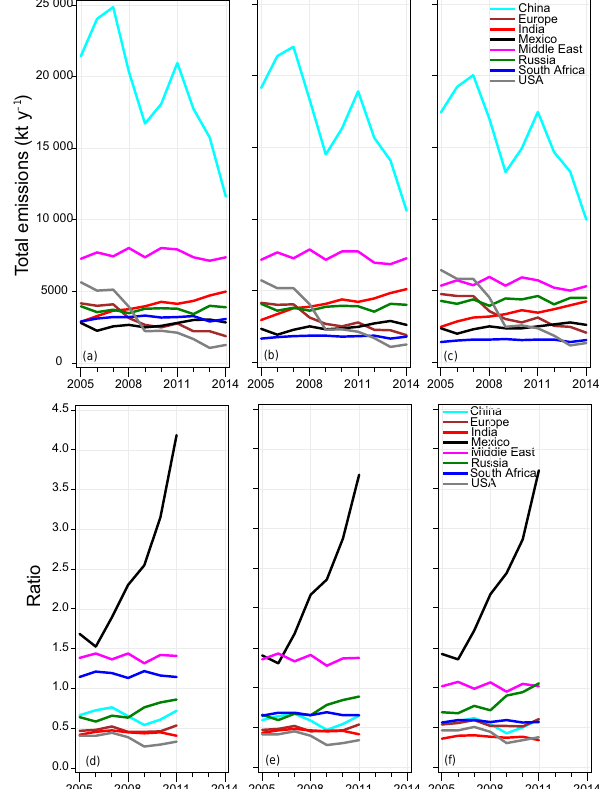
Figure 13. (a – c) Time series of total annual SO 2 emissions by country/region calculated for the period 2005–2014, and (d – f) time series of the ratios between OMI-estimated and reported annual emissions by country/region. Emissions were calculated using con- stant AMF = 0.36 (a, d) , AMF values that depend on the site alti- tude only (b, e) , and AMF values that were calculated using the site altitude, albedo, and PBL height (c, f) . Note that western and central Europe are labelled jointly as